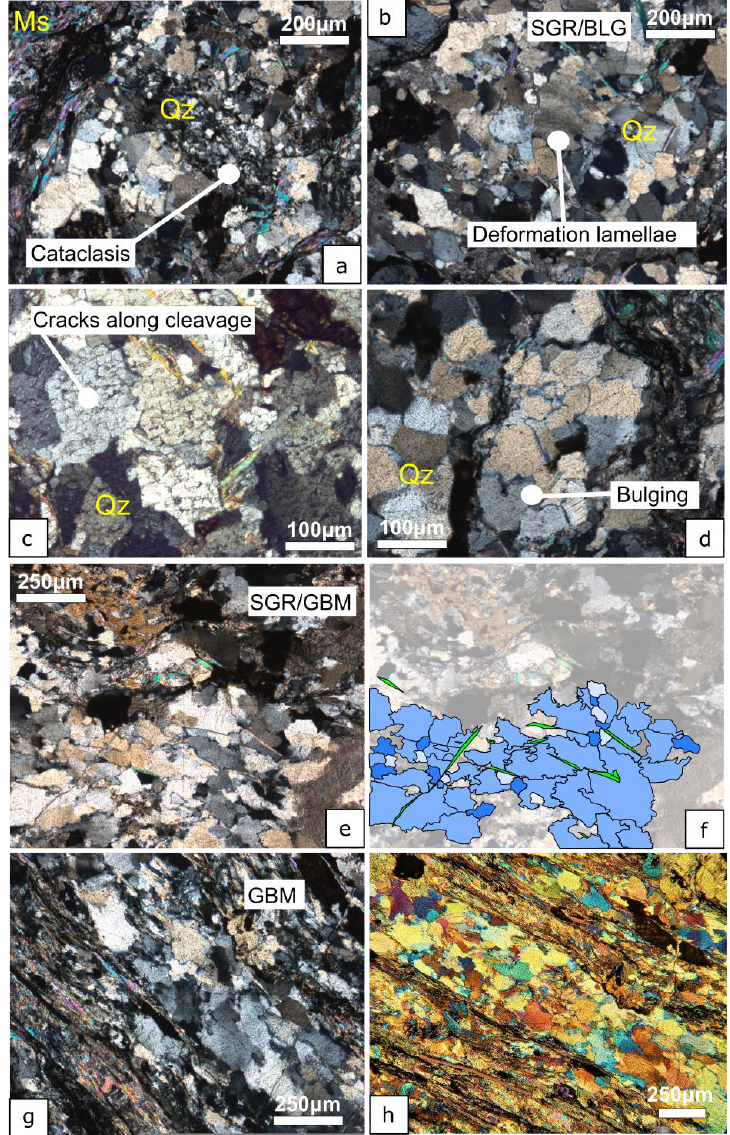
Figure 8. Thin sections under crossed-polarized light; ( a ) cataclastic breaking of quartz parallel to the fault core foliation; Evidence of deformation lamellae ( b ), brittle deformation inside quartz ( c ), bulging ( b , d ) and grain boundary migration ( e – h ). ( e , f ) are the same pictures in which we highlight the shape of the quartz boundaries in ( f ), as well as the formation of new subgrains with an average size of 150 µ m. ( g , h ) are the same portion of the thin section under cross-polarized light ( g ) and with lambda plate inserted ( h